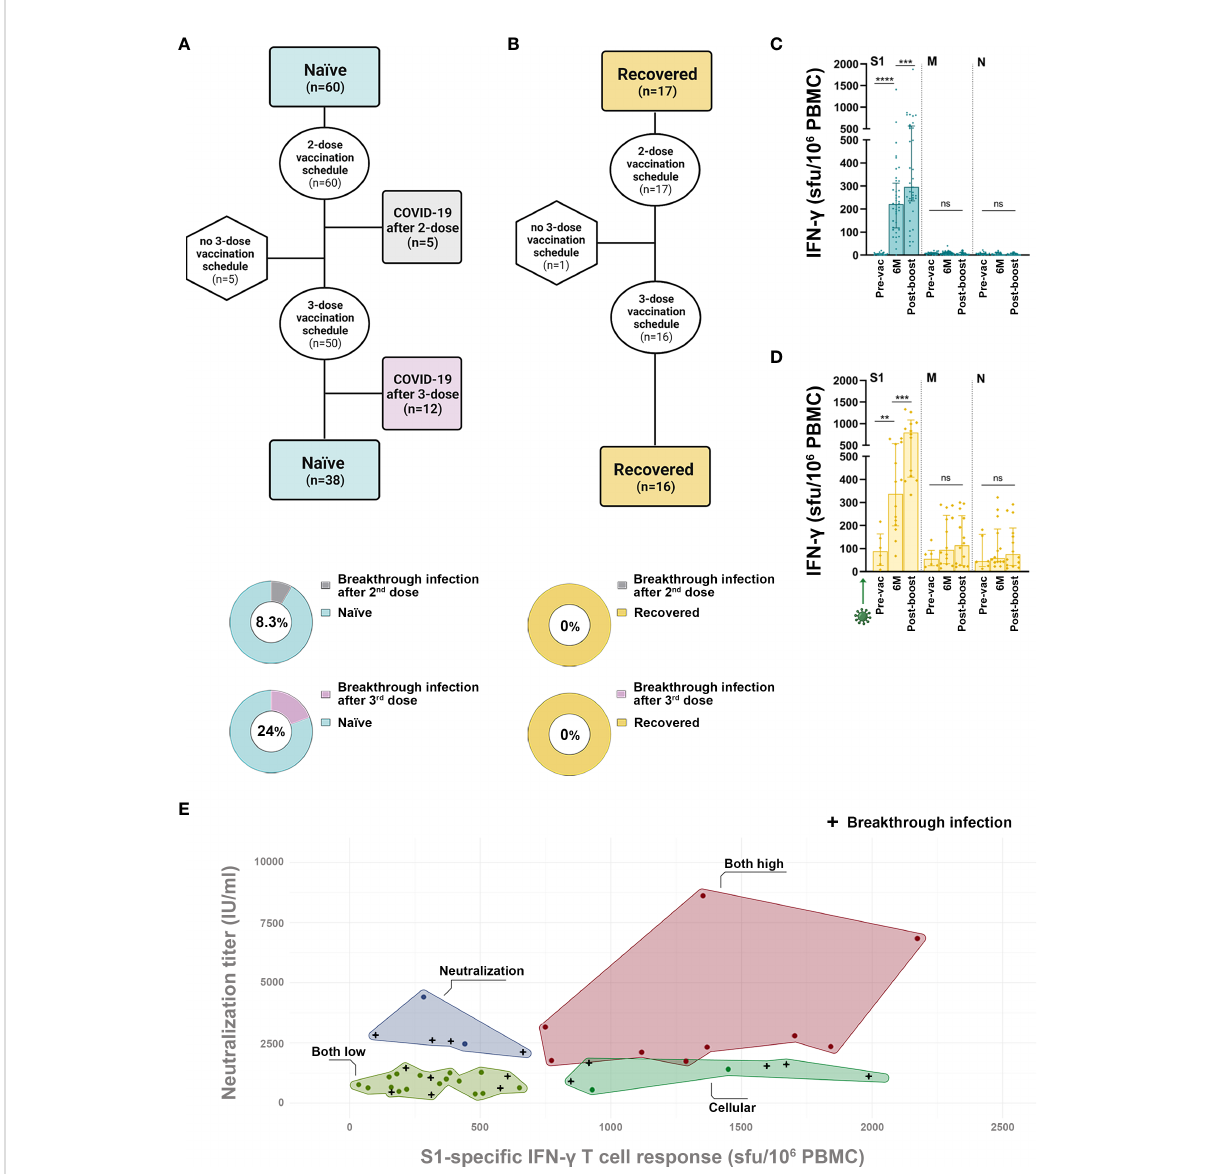
FIGURE 2 Factors associated with protection against breakthrough infection after SARS-CoV-2 vaccination. (A, B) Flowchart of SARS-CoV-2 naïve (A) and recovered (B) individuals included in the study and the frequency of SARS-CoV-2 infection reported after the second or third vaccine dose. (C, D) SARS-CoV-2-speci fi c IFN- g -producing T cell responses reactive to the S1, M and N proteins in subjects who remained SARS-CoV-2 naïve during follow-up (C) and in recovered (D) individuals. (E) Clustering based on S1-IFN- g -producing T cell average and neutralizing titer average 15 days after the second BNT162b2 dose, when the vaccine-elicited immune response peaked, in naïve individuals. Green arrows represent the time of SARS-CoV-2 infection. Black crosses represent SARS-CoV-2-infected subjects after mRNA vaccination. Horizontal bars and whiskers represent median values and interquartile ranges, respectively. The signi fi cance between groups was determined using Mann-Whitney or Kruskal-Wallis tests, ns: not statistically signi fi cant, **p<0.01, ***p<0.001,